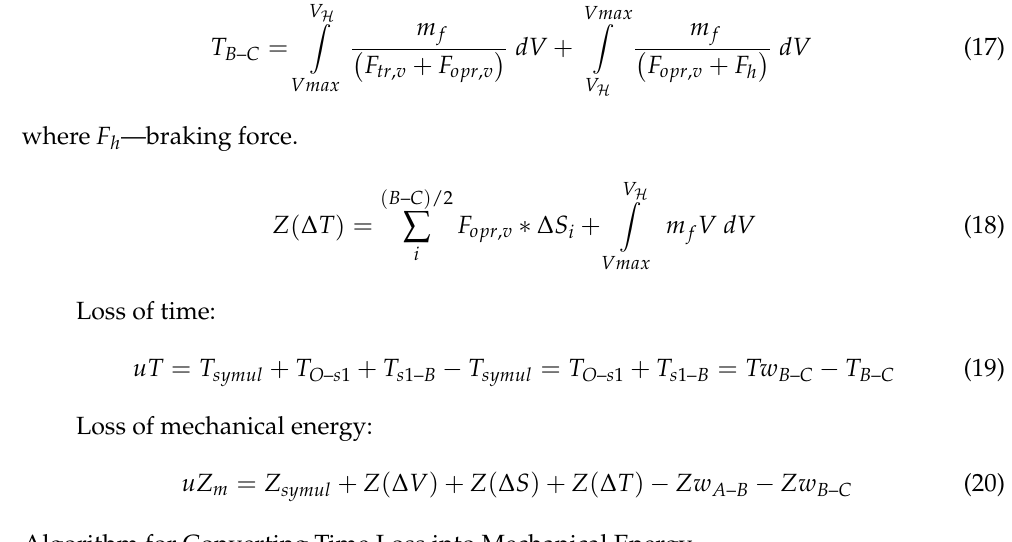
Algorithm for Converting Time Loss into Mechanical